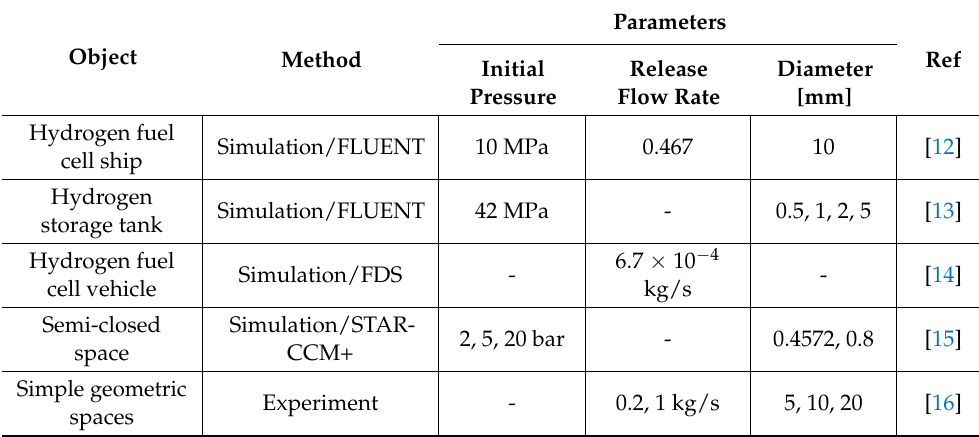
Table 1. Recent studies related to hydrogen release and